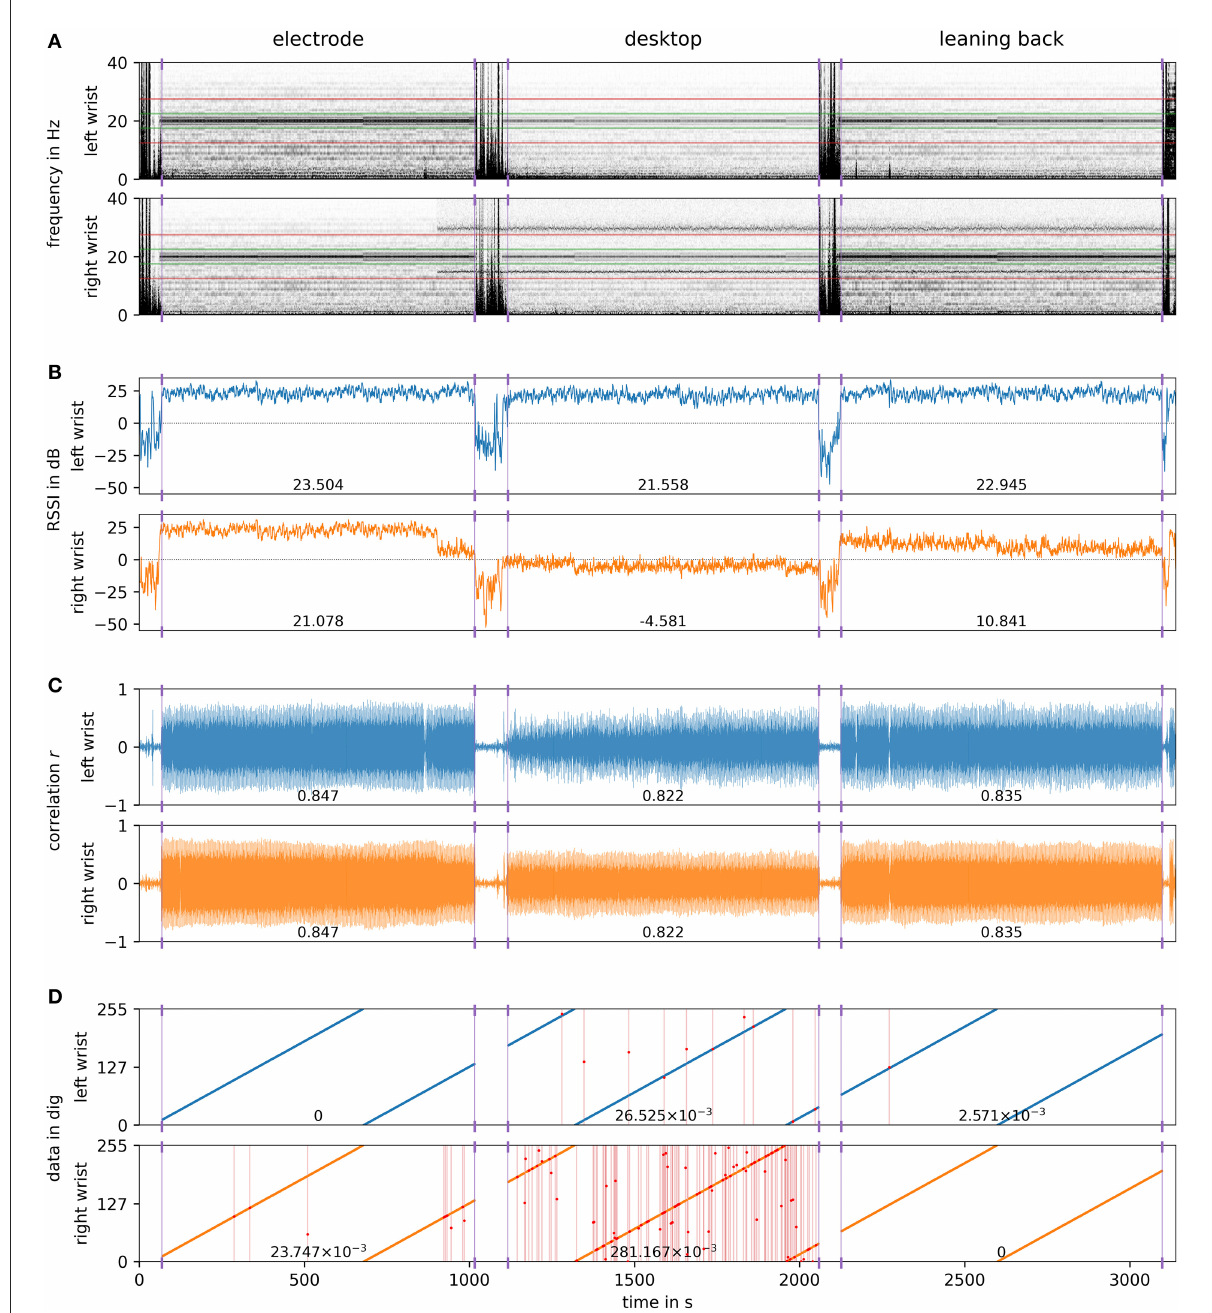
FIGURE11 Output of the processing pipeline for the desktop experiment: (A) short-time Fourier transform (STFT) with a window length of 4s (512samples) and 75% overlap, presence of the signal core in 17 . 5–22 . 5Hz (green lines) and in-band noise in 12 . 5–17 . 5Hz and 22 . 5–27 . 5Hz (red lines); (B) received signal strength indicator (RSSI) derived from the signal core and the adjacent in-band noise, resulting in average RSSI of the segments; (C) Pearson’s r , normalized cross-correlation, maxima of the detected landmarks resulting in mean ¯ r of the segments; (D) decoded data d and damaged information (red) due to erroneously detected pulses, resulting in PER of the segments.